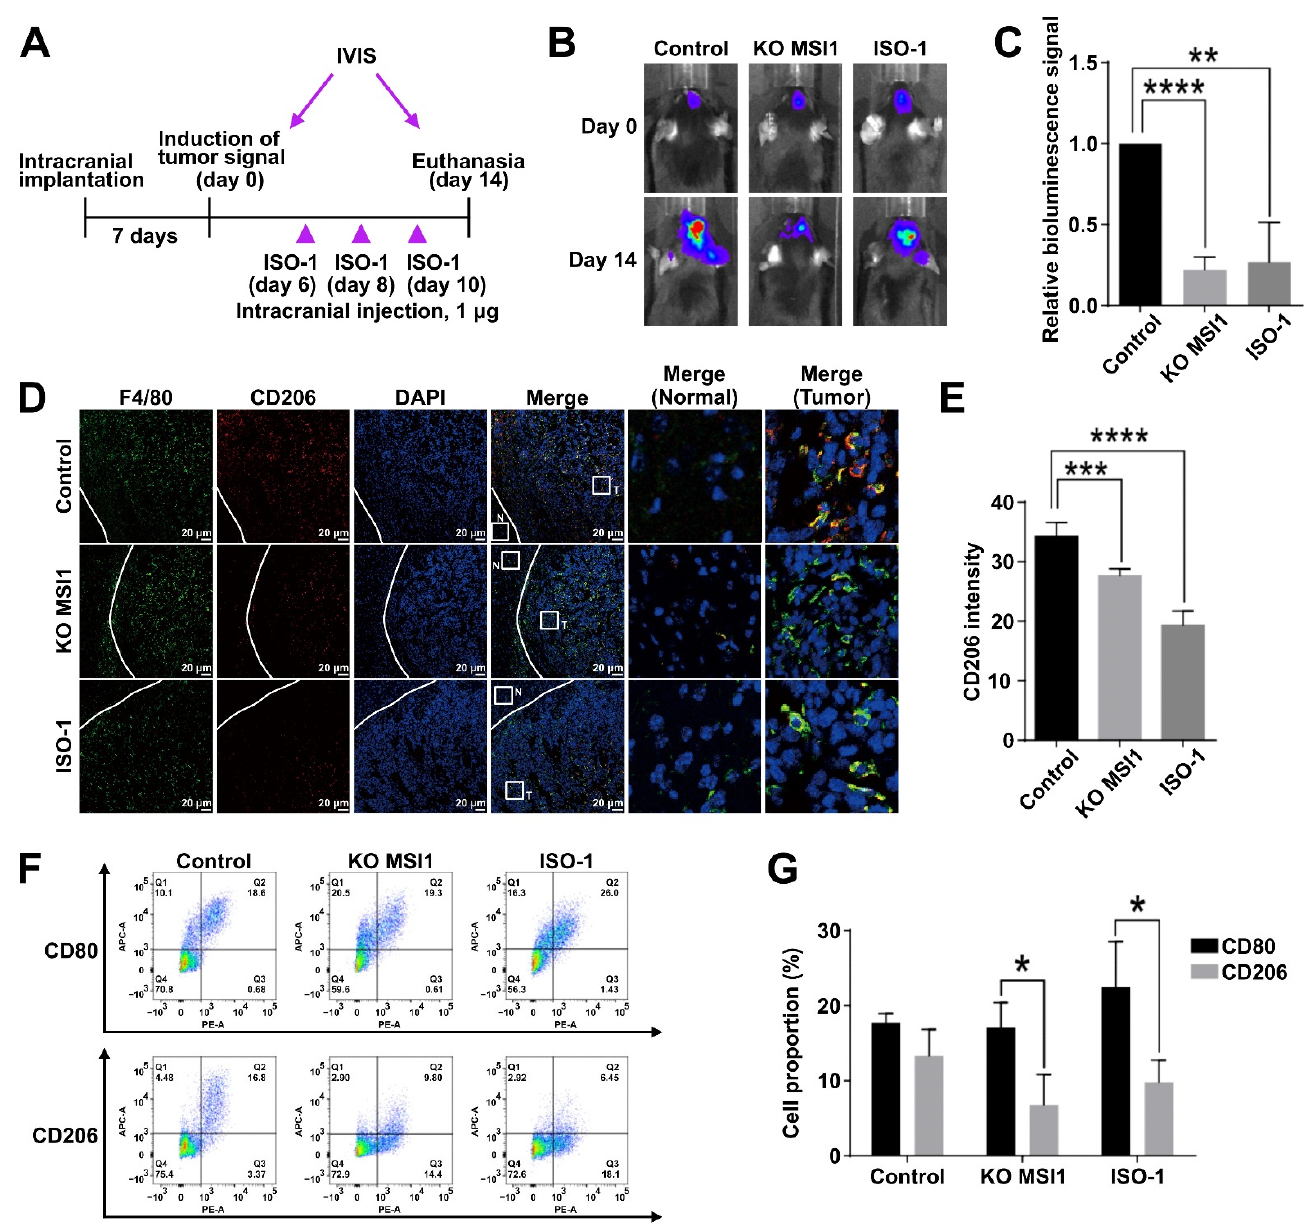
Figure 5. Inhibition of MIF1 causes suppression of GBM growth in vivo with concomitant reduction of the M2 macrophage population. ( A ) Schematic of the experimental design to test the effect of ISO-1 on intracranial tumor growth. GL261-Luc cells were intracranially implanted in mice ( n = 3) and inoculated for seven days until the signal of tumor induction was observed by the IVIS luciferase imaging system (defined as day 0). The MIF-1 inhibitor ISO-1 (1 μ g) was intracranially injected at days 6, 8 and 10. The signals of intracranial tumors were monitored by the IVIS luciferase imaging system till day 14 when the mice were sacrificed. ( B ) Bioluminescent imaging visualization (IVIS) of the indicated GL261-Luc-derived tumors. ( C ) Quantification of the bioluminescence signal from tumors in ( B ). Means with SD error bars are shown, n = 3, ** p < 0.01, **** p < 0.0001 (Student’s t -test). ( D ) Immunofluorescent staining of F4/80 (general macrophage marker) and CD206 (M2 marker) in the cross-sections of the indicated GL261-Luc-derived intracranial tumors. Tumor (T) and surrounding normal (N) tissue are marked by white squares and zoomed in the right panel. ( E ) Quantification of the CD206 immunofluorescent signal intensity in ( D ). Means are shown with SD error bars, n = 3, *** p < 0.005, **** p < 0.0001 (Student’s t -test). ( F ) Flow cytometry analysis of the proportion of CD80 (M1)- and CD206 (M2)-expressing macrophages in the indicated GL261-Luc-derived intracranial tumors. ( G ) Quantification of the proportion of CD80- and CD206-expressing macrophages in ( F ). Mean values are shown with SD error bars, n = 3, * p < 0.05 (Student’s t -test).